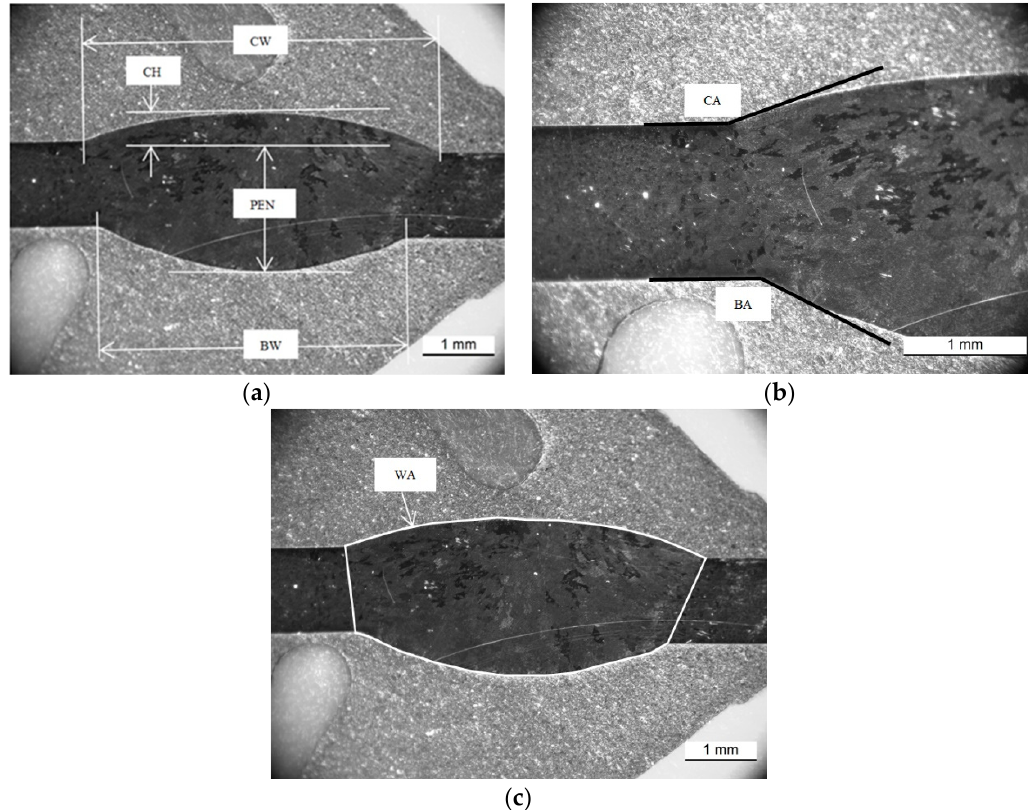
Figure 1. Bead geometry features measured for obtaining the data: ( a ) crown height, crown width, penetration, back width; ( b ) crown angle, back angle; ( c ) weld cross-sectional area. Welding parameters used for this weld: I p = 90 A; TS = 2 mm/s; f = 1.5 Hz; R = 300 mm/min; D = 1 mm; N = 0%.